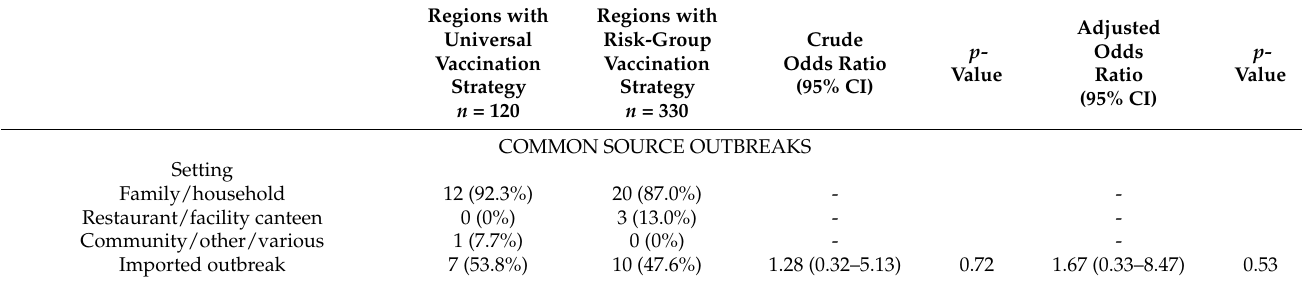
Table 3. Characteristics of common source and person-to-person hepatitis A outbreaks in regions with different vaccination strategies. Spain,